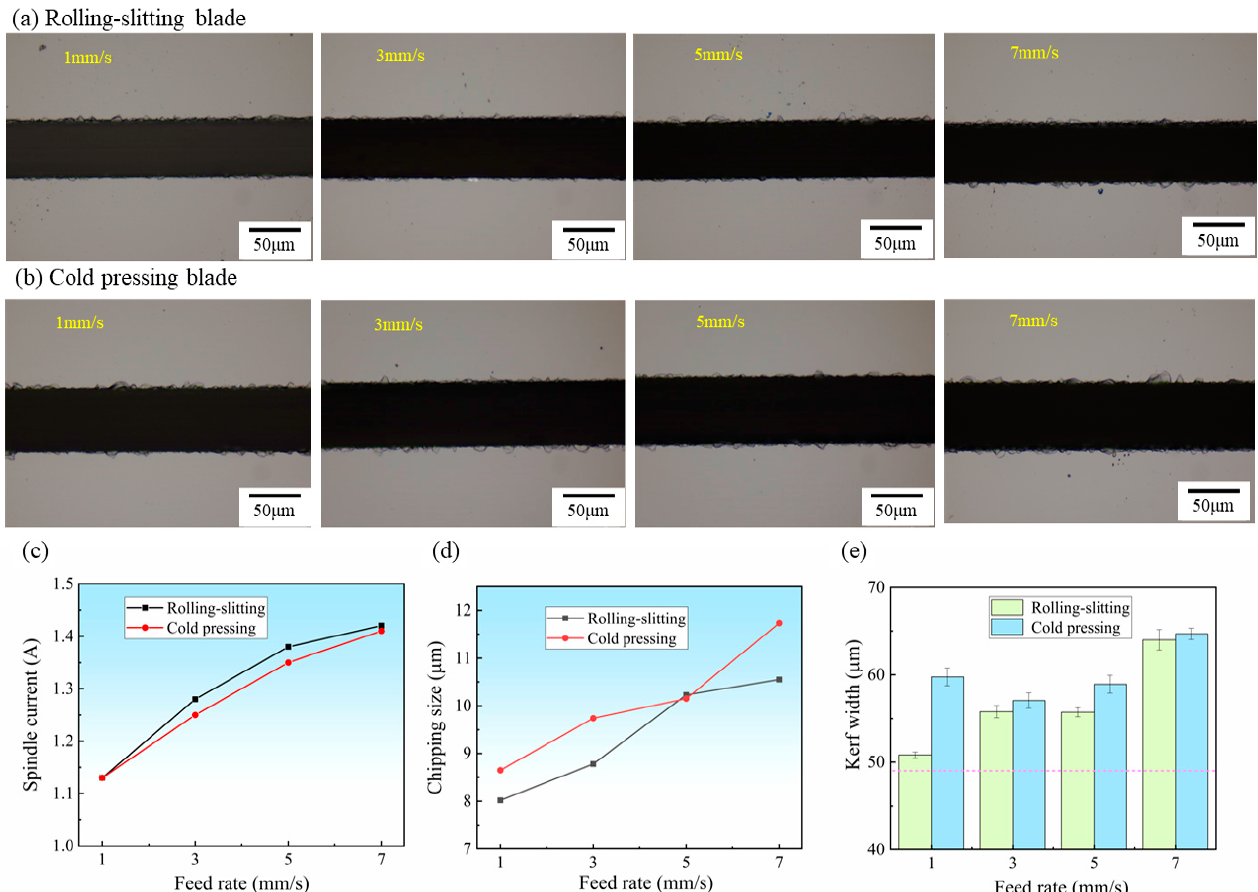
Figure 9. Result of SiC wafers diced at different feed rates, Spindle speed n = 22,000 rpm dicing depth ap = 0.2 mm: ( a , b ) Surface morphology of SiC, ( c ) Spindle current, ( d ) Maximum chipping size, ( e ) Kerf